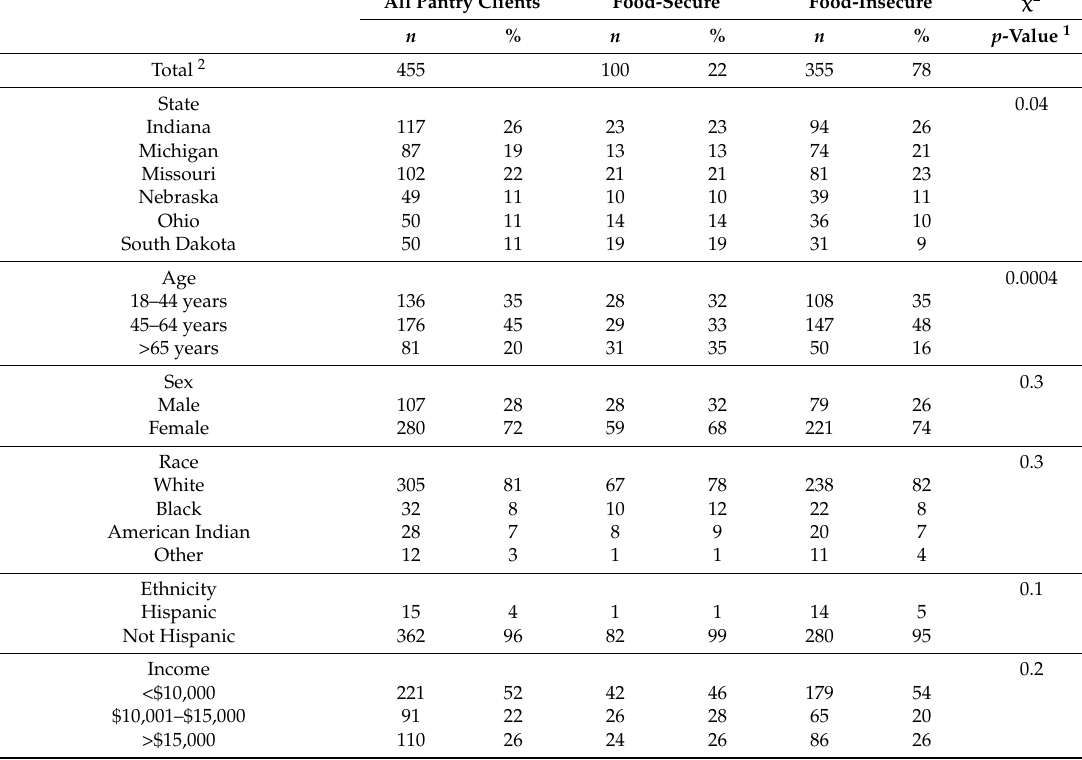
Table 1. Characteristics of a multistate sample of rural, Midwestern, adult emergency food pantry clients by food security status ( n =